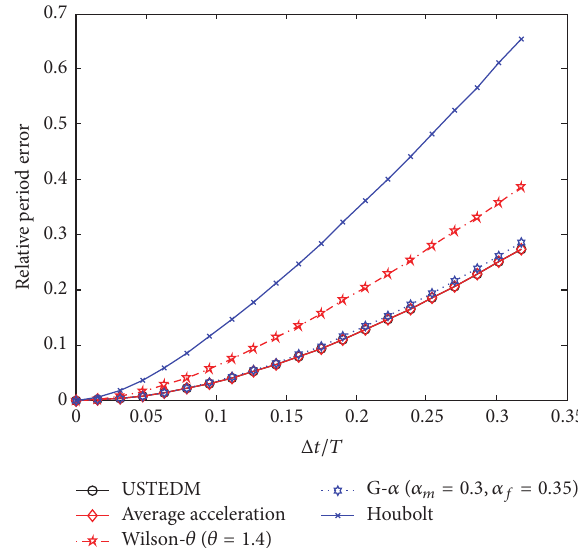
Figure 2: Comparison of spectral radius.